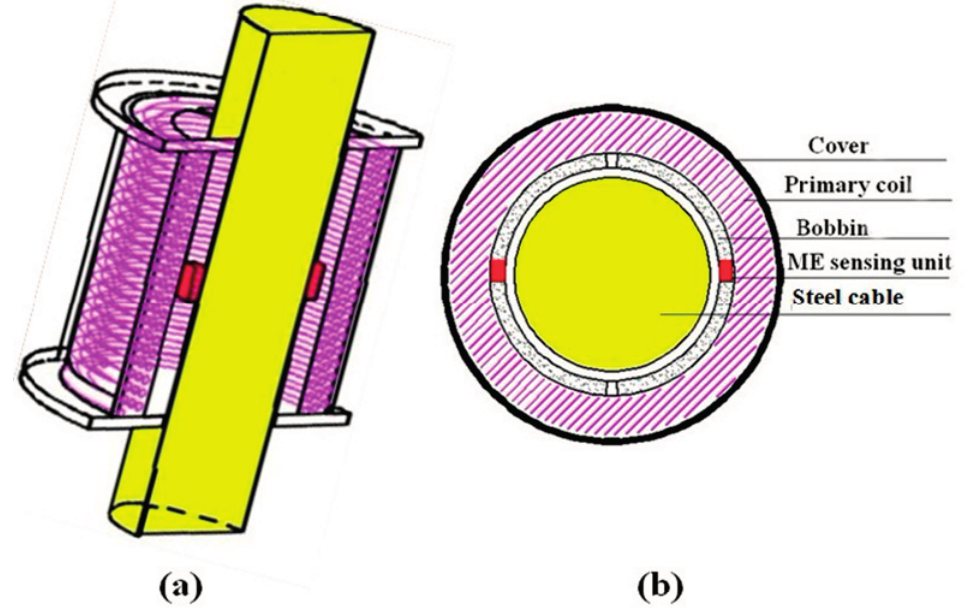
Figure 4. Structure of the EME sensor: (a) Longitudinal section; and ( b )